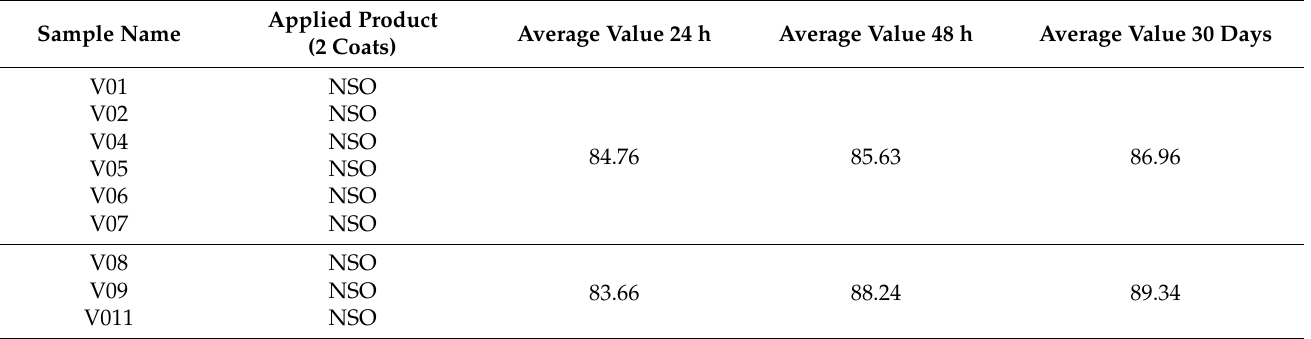
Table 3. Average values of the wettability